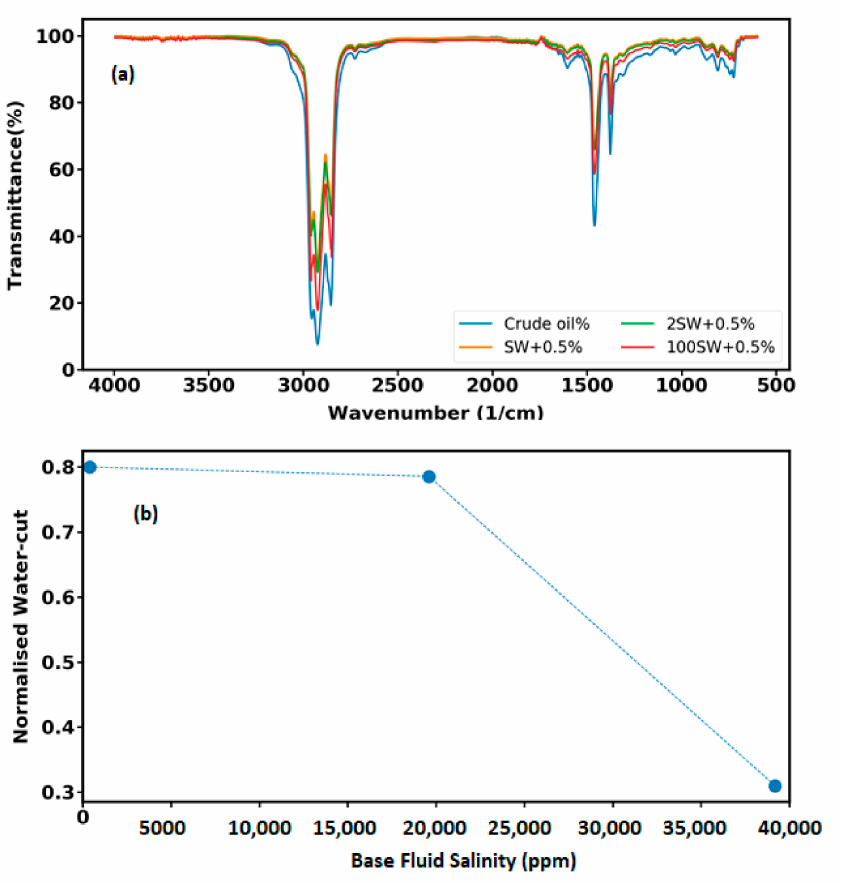
Figure 12. ( a ) Results of FTIR spectroscopy versus wavenumber for brine solutions with different ionic strength. ( b ) The ratio between water-cut of original crude oil and amount of water after contacting with water versus salinity level of base